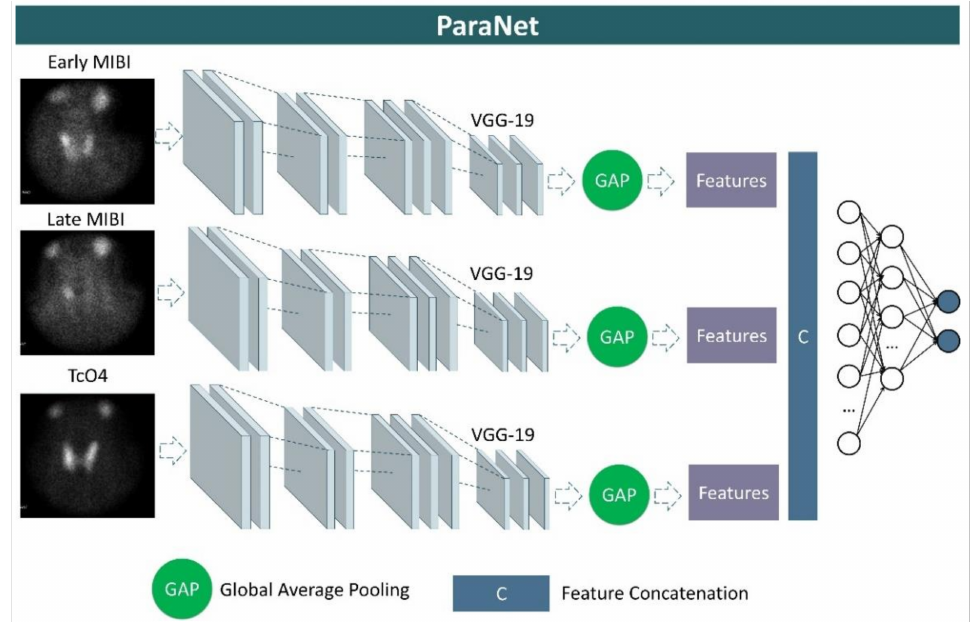
Figure 2. Graphical representation of